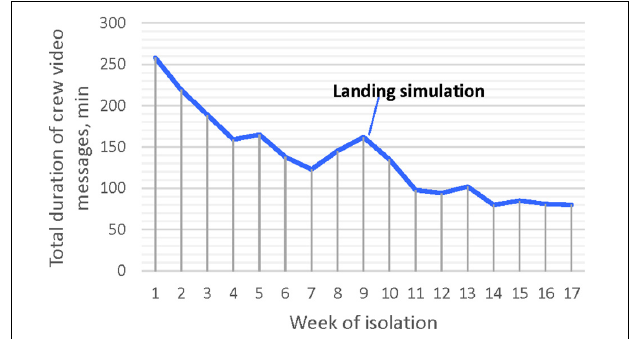
FIGURE 1 | Video messages of the crew duration under isolation.